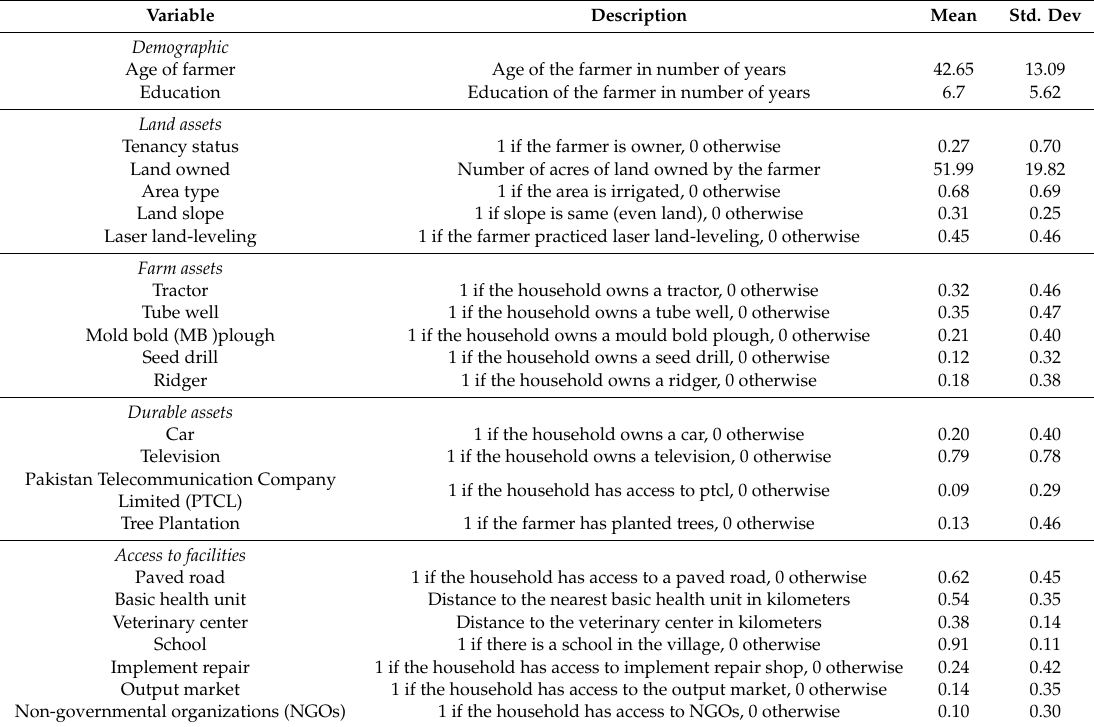
Table 4. Data and description of